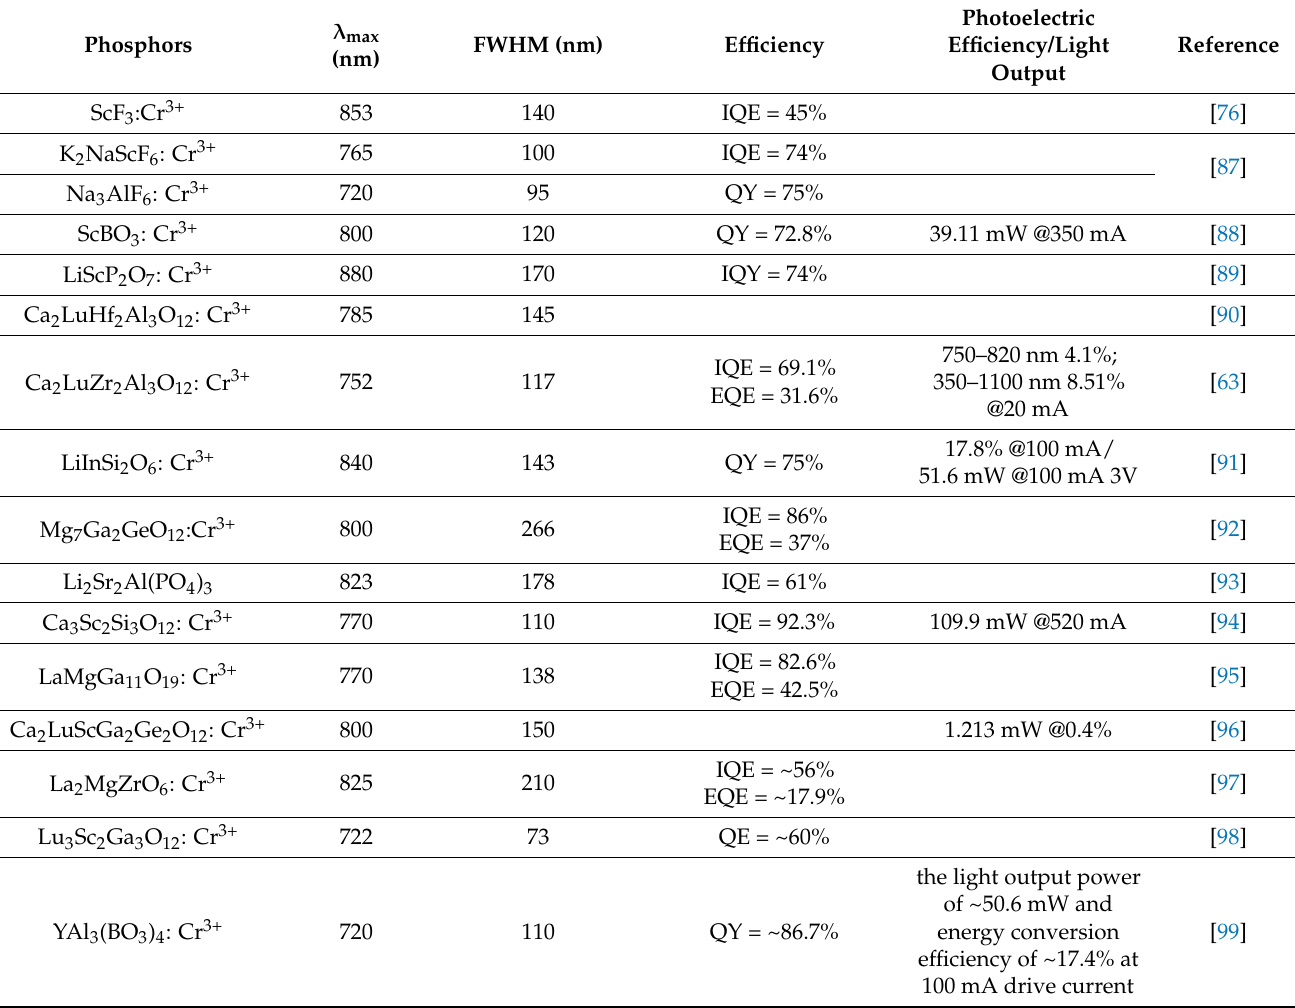
Table 1. A series of Cr 3+ -doped NIR